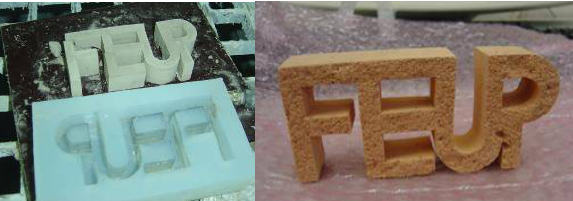
Figure 5. Silicone mould and decorative ceramic part cast on it.